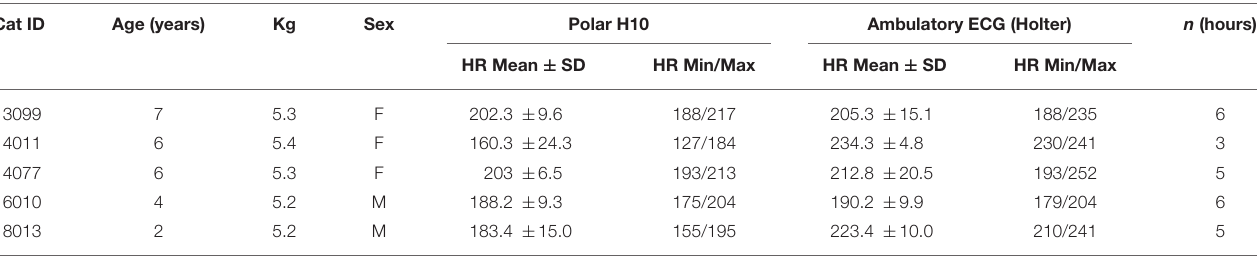
TABLE 1 | Cats used for Polar-Holter cardiac data comparisons for this study, showing mean, min, and max HR recorded for the duration of data collection for both methods (Polar H10 filtered data, and the Holter data). Cat ID